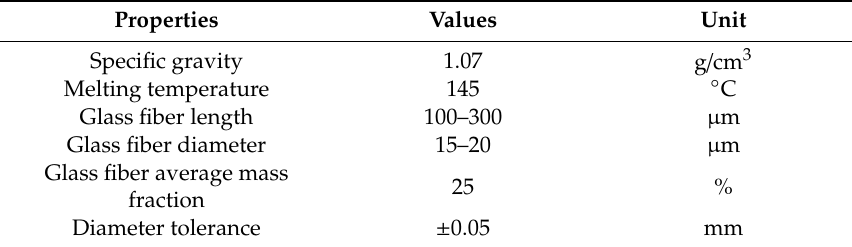
Table 1. Physical properties of polypropylene filament reinforced by short glass